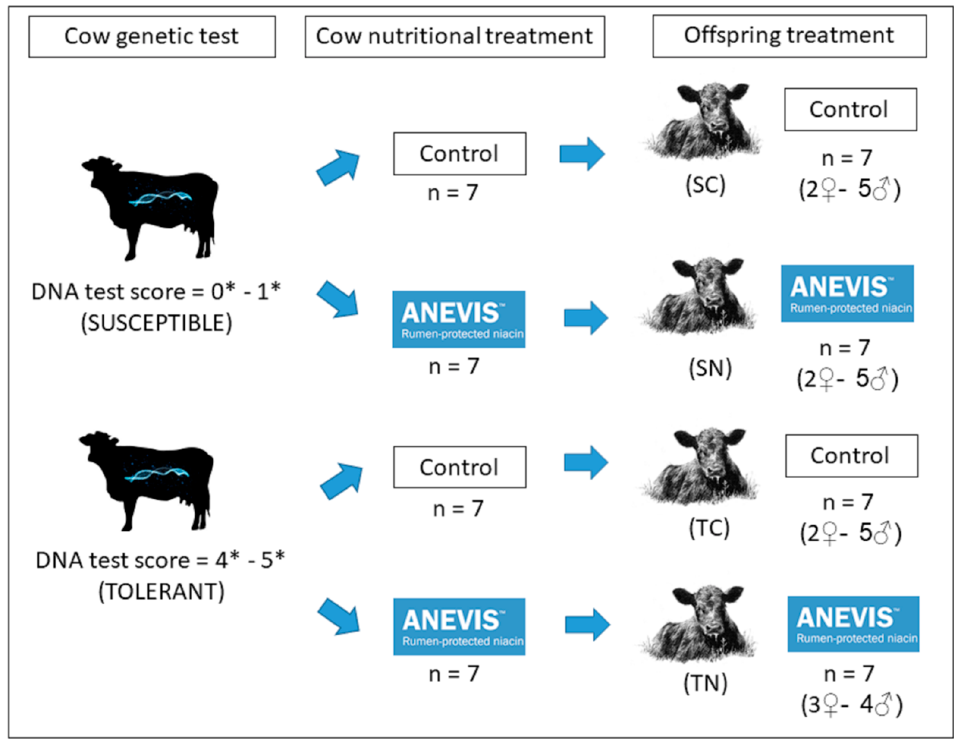
Figure 1. Experimental design. Abbreviations: SC: Susceptible, control; SN: Susceptible, niacin; TC: Tolerant, control; TN: Tolerant, niacin; ♀ : heifers; ♂ : steers, *: stars.